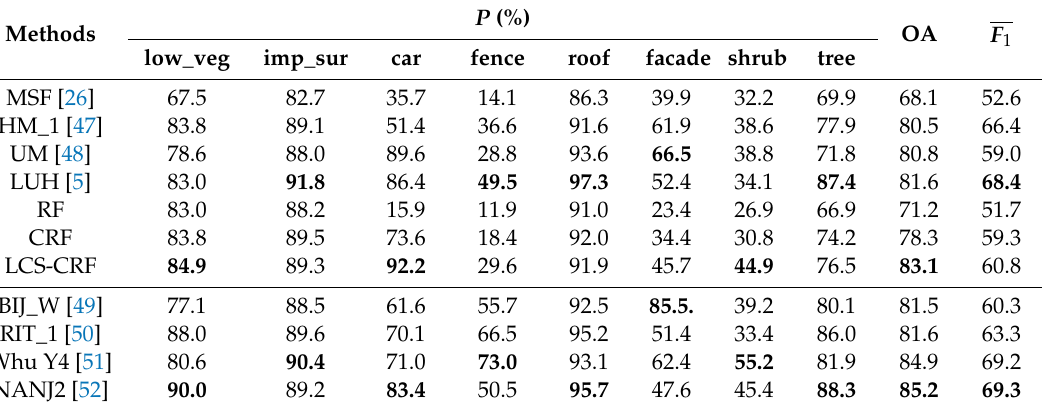
MSF: the method based on multi-scale features.